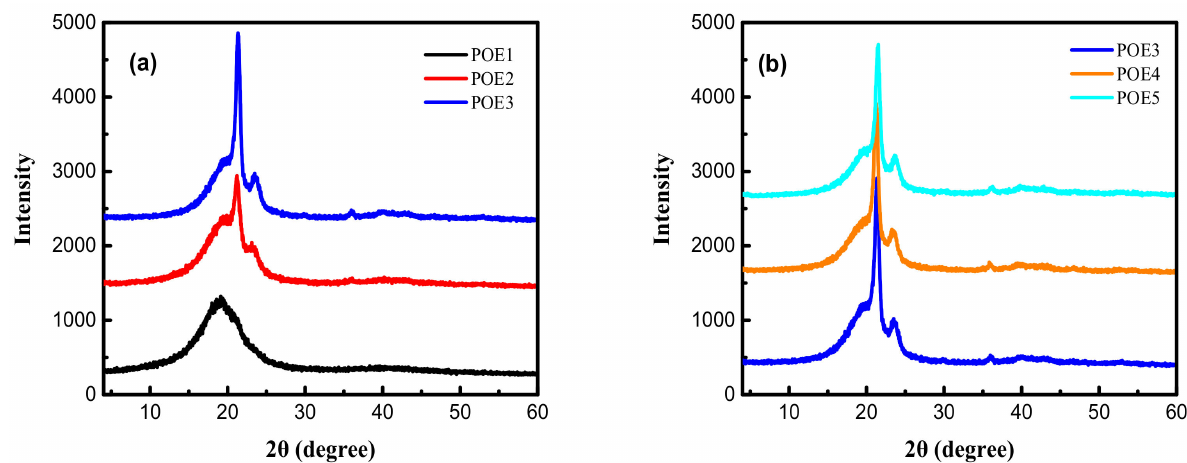
Figure 1. X-ray diffractograms of different samples at room temperature. ( a ) POE samples with same Melting Index (MI); ( b ) POE samples with same octene content.